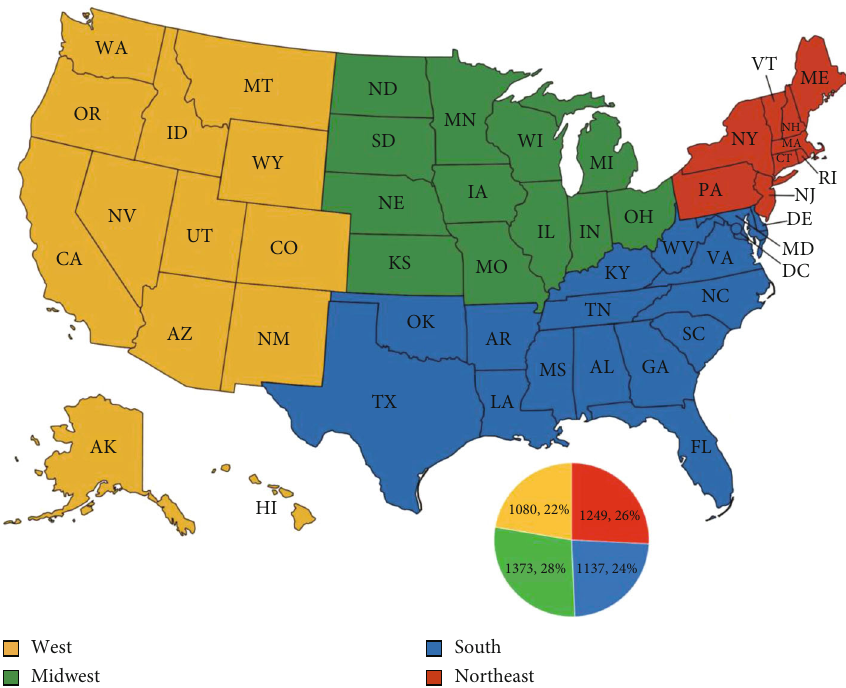
Figure 2: Map of the United States showing categorization of each state into geographic regions and pie chart demonstrating total IH admissions per geographic region. Table 2: Propranolol treatment related complications. Number of patients